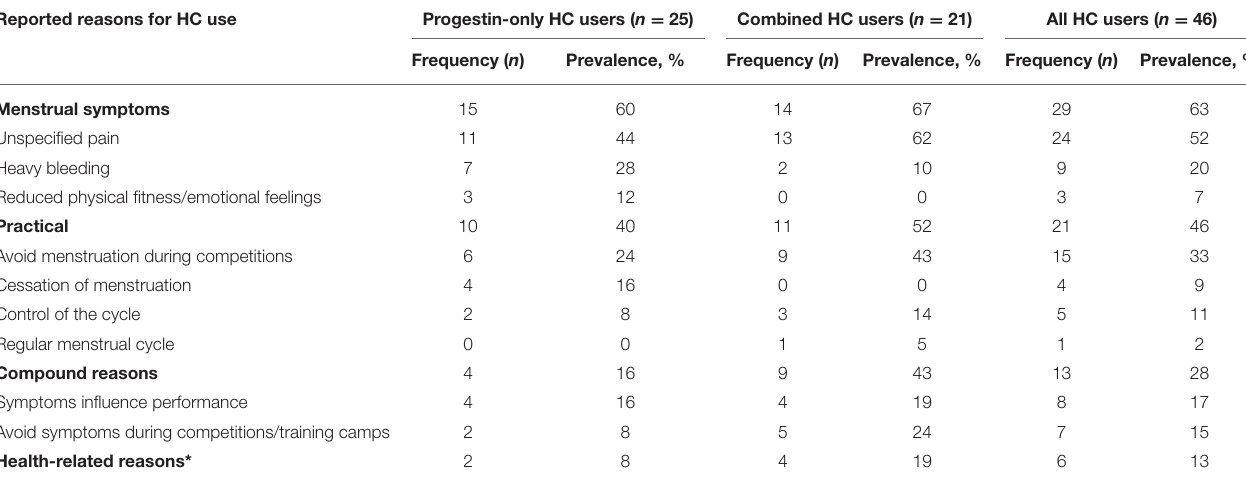
TABLE 2 | Frequency and prevalence for hormonal contraceptive (HC) use.